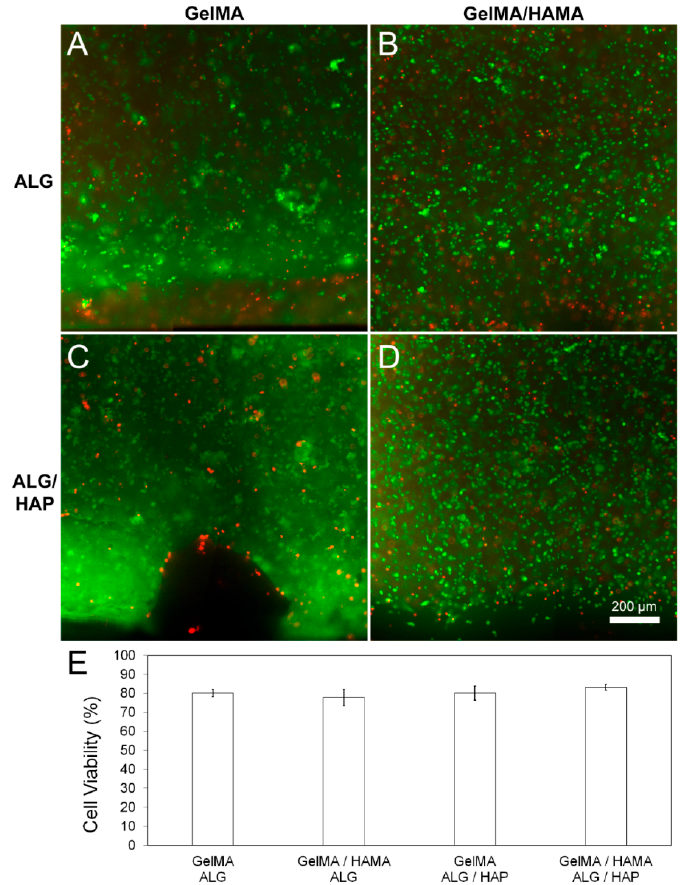
Figure 4. Cell viability in hydrogel groups on day 1 of culture. Images and quantitated data of cell viability measured using FDA/PI assay on day 1 of culture. Quantification and image analysis was performed using ImageJ. ( A ): GelMA-ALG; ( B ): GelMA/HAMA-ALG; ( C ): GelMA/ALG-HAP; ( D ): GelMA-HAMA/ALG-HAP; ( E ): quantified viability from n = 3 samples per group. Scale bar 200 µm.